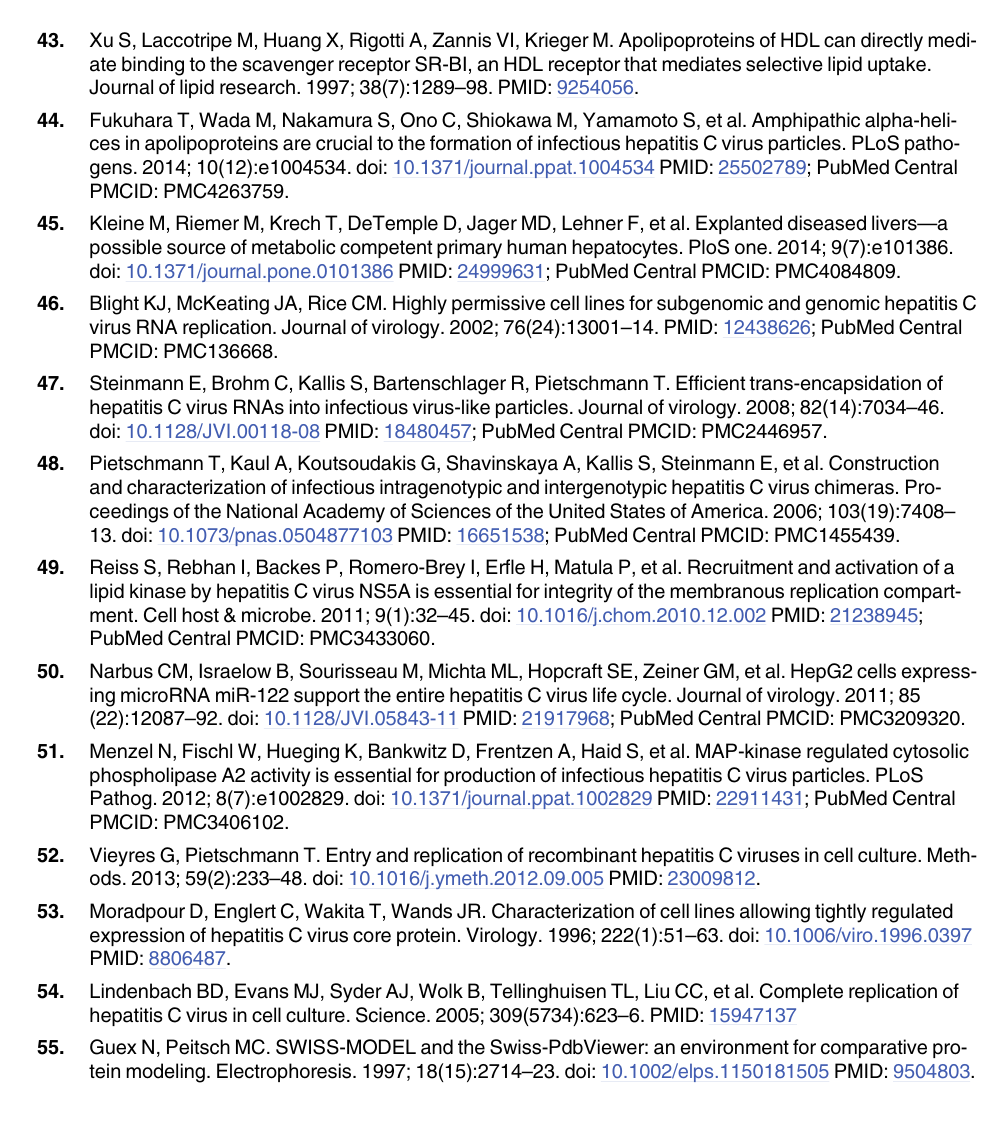
PLOS ONE | DOI:10.1371/journal.pone.0134529 July 30,